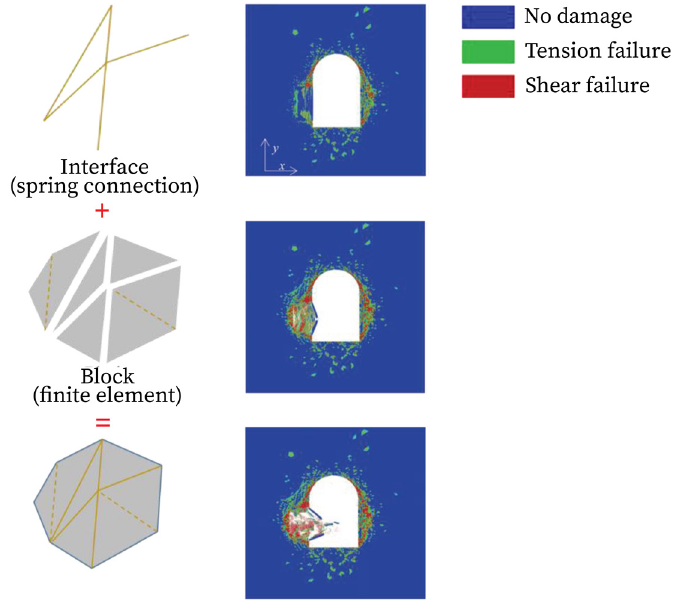
Figure 6. The principle schematic of GDEM numerical model ( left ) and the failure process of bending-bulging rockburst ( right ) [114].